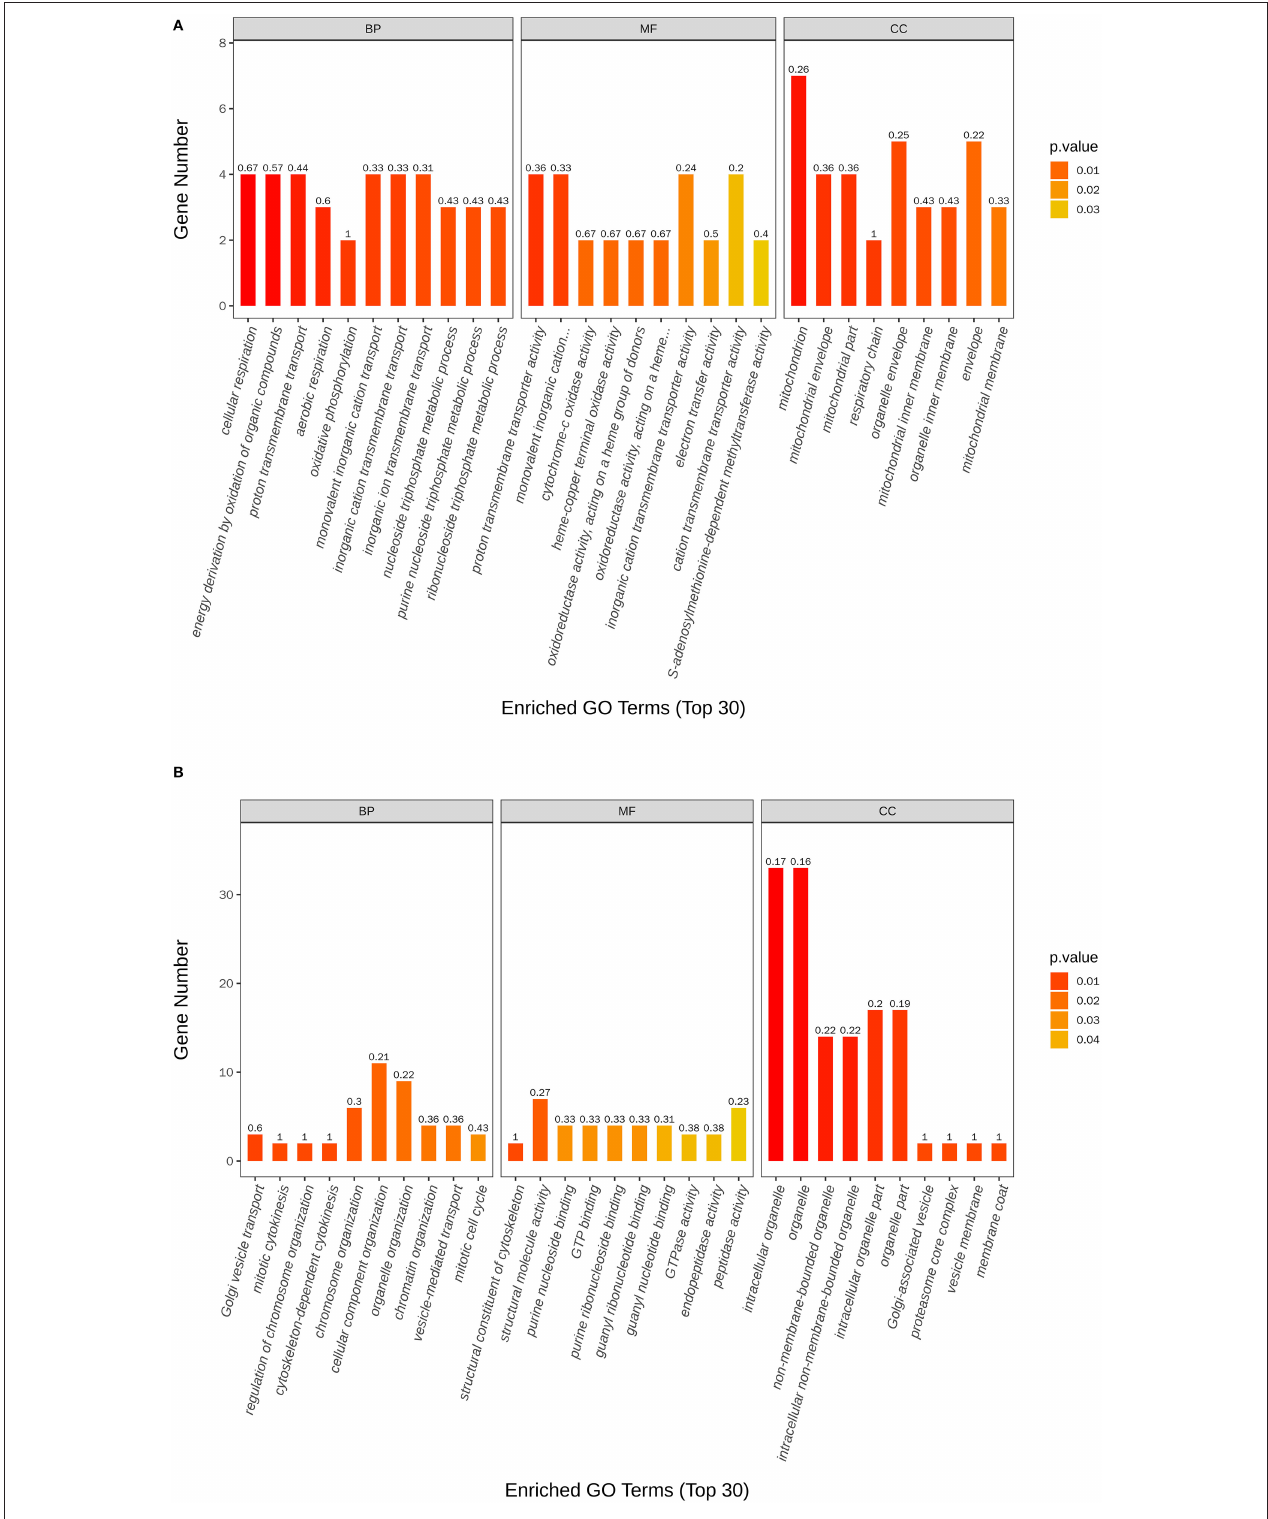
FIGURE 8 | Scatter plots of the top 20 GO enrichment of upregulated (A) and downregulated (B) DEGs between control and nanoemulsion treatment.